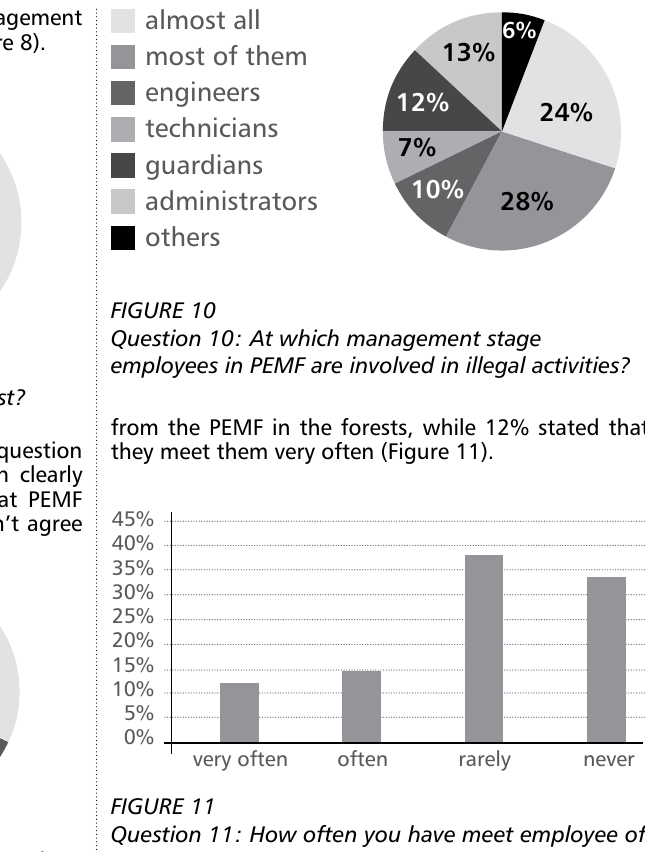
Question 11: How often you have meet employee